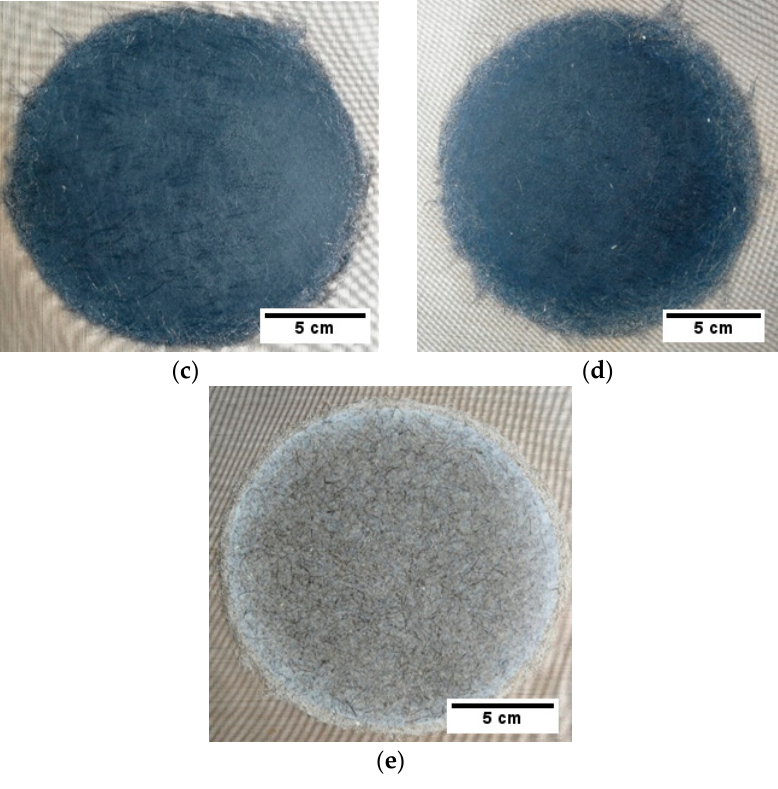
Figure 2. Finished composites of ( a ) sample 1, 100% rCF; ( b ) sample 2, 75% rCF and 25% flax; ( c ) sample 3, 50% rCF and 50% flax; ( d ) sample 4, 25% rCF and 75% flax; and ( e ) sample 5, 100% flax.